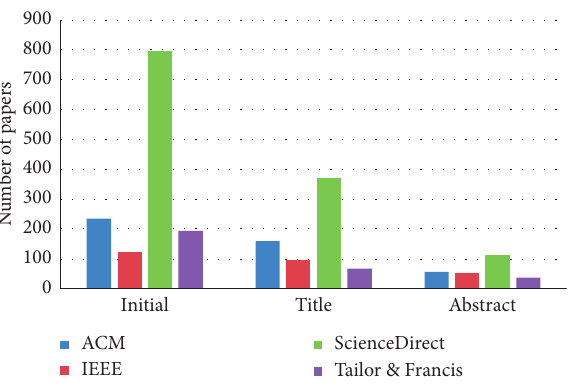
Figure 9: Overall filtering process of papers.